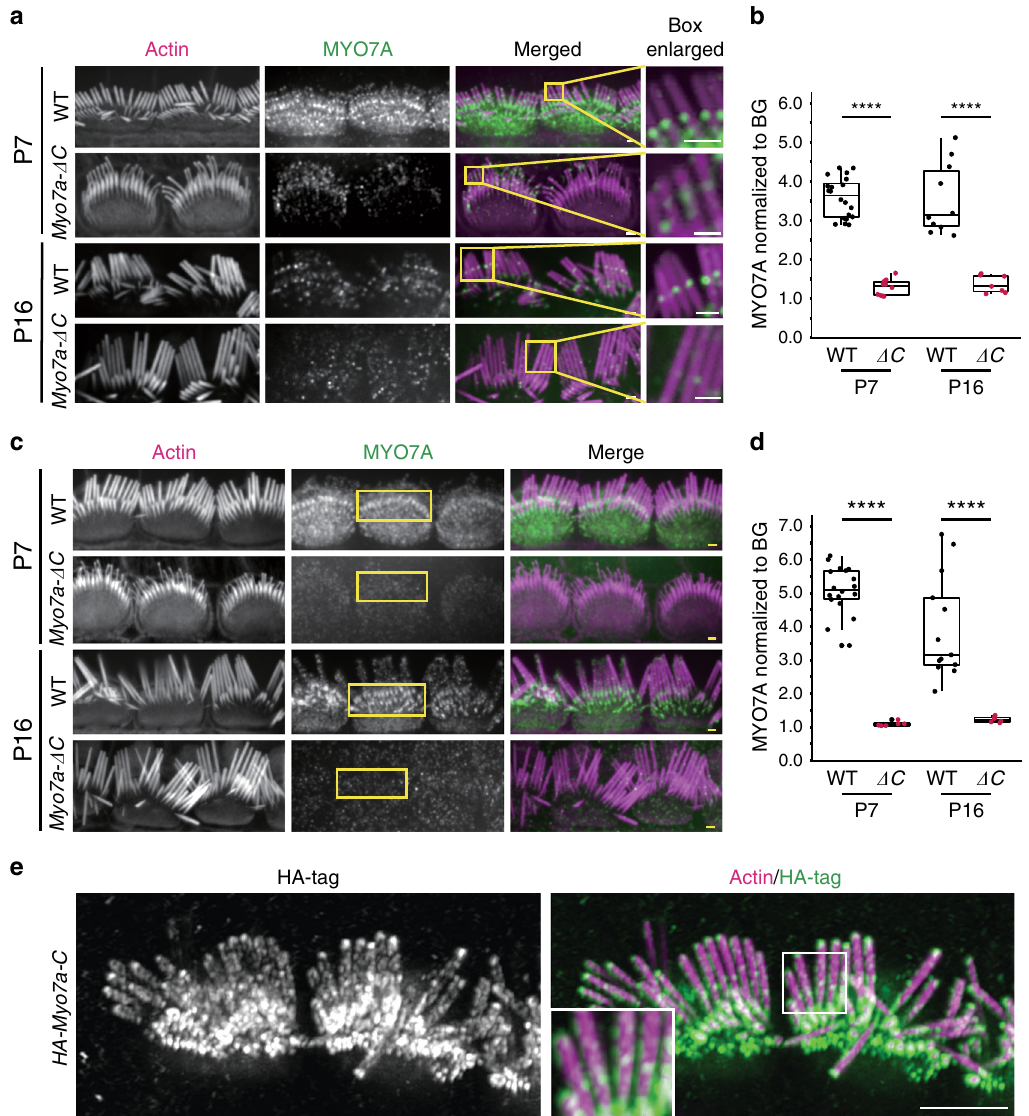
Fig. 4 Reduced levels of MYO7A at the UTLD and stereocilia base of Myo7a- Δ C mice. a MYO7A immunoreactivity at the UTLD in WT and Myo7a- Δ C mice at P7 and P16. MYO7A is detected at the UTLD of Myo7a- Δ C IHCs, but the intensity is reduced compared with WT (scale bars: 1 μ m). b MYO7A in the UTLD of Myo7a- Δ C mice decreased by 68% at P7 ( p < 1e − 3) and 58% at P16 ( p < 1e − 3) compared with WT. The fl uorescence intensity of MYO7A puncta was normalized against a dark background near the UTLD staining in the same image and z-section. Mean normalized intensities of MYO7A at the UTLD, averaged per cell: P7: WT = 3.58 ± 0.51, Myo7a- Δ C = 1.28 ± 0.21, p = 2.73e − 16; P16: WT = 3.59 ± 1.00, Myo7a- Δ C = 1.37 ± 0.23, p = 4.30e − 05. N = number of cells. Numbers analyzed per genotype and age (UTLDs; cells; animals): WT, P7 (157; 20; 4), P16 (73; 10; 4). Myo7a- Δ C , P7 (62; 10; 4), P16 (35; 7; 4). c MYO7A immunoreactivity at the stereocilia base of IHCs of WT and Myo7a- Δ C at P7 and P16 (scale bars: 1 μ m). d Quanti fi cation of MYO7A at the stereocilia base. MYO7A puncta were normalized against a dark background in the image. Mean normalized intensities of MYO7A at the base, averaged per cell: P7: WT = 5.09 ± 0.71, Myo7a- Δ C = 1.093 ± 0.068, p = 6.98e − 15; P16: WT = 3.96 ± 1.54, Myo7a- Δ C = 1.23 ± 0.089, p = 3.35e − 05. N = number of cells. Numbers analyzed per genotype and age (stereocilia bases; cells; animals): WT P7 (406; 18; 4), P16 (187; 13; 4); Myo7a- Δ C: P7 (64; 6; 4), P16 (79; 6; 4). p values in b and d were derived from two-tailed, unpaired t -tests. Boxplots show medians, 25th and 75th percentiles as box limits, and minima and maxima as whiskers. e HA-immuno fl uorescence resolved the membrane-adjacent localization of HA-MYO7A-C in the HA-Myo7a-C KI mice, as well as MYO7A enrichment at the predicted site of the UTLD and the stereocilia base (and tips in some cases). The inset shows the HA-tag signal at the UTLD at higher magni fi cation (scale bar: 5 μ m). Source data are provided in the Source Data fi